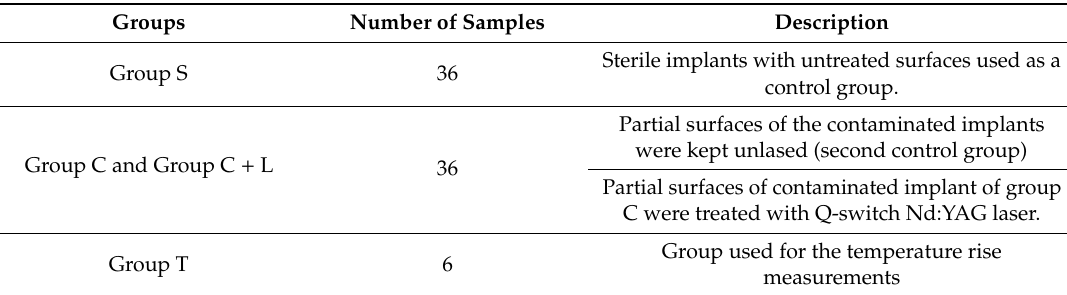
Table 1. Experimental and Control